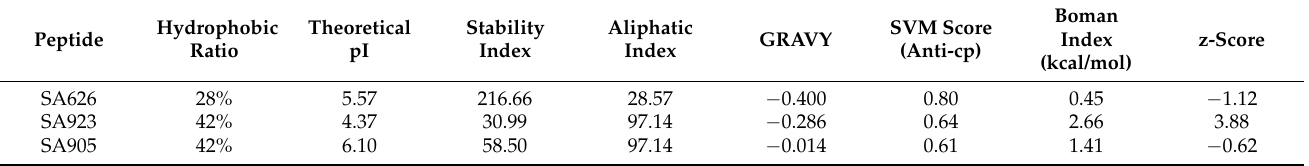
Table 3. Physicochemical properties of peptides sourced through computational